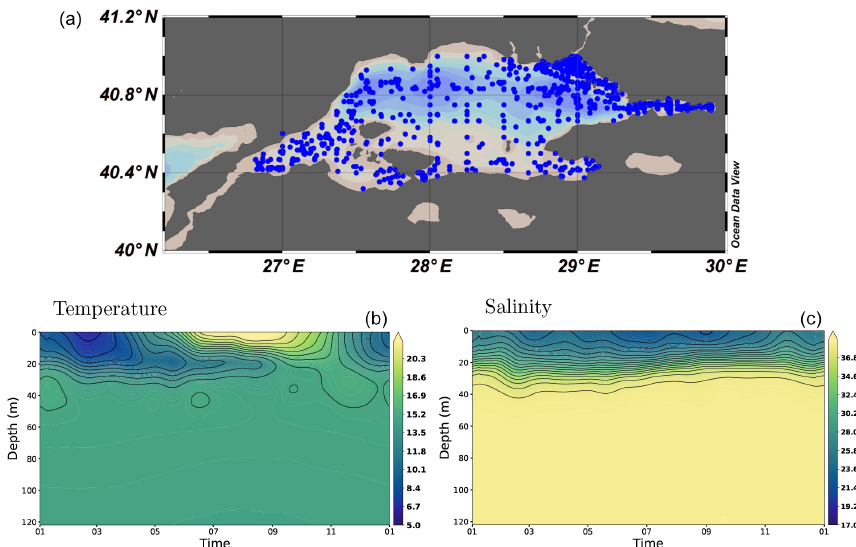
Figure 4. Time series of daily climatological salinity (b) and temperature (c) profiles and locations of the CTD stations (a) applied for relaxation at the Marmara box shown in Fig.